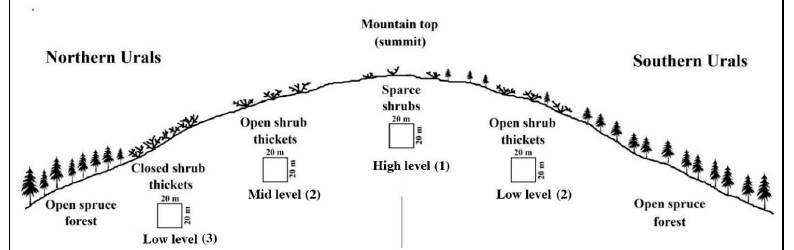
Figure 3. Scheme of changes in vegetation and sampling along altitudinal transects.